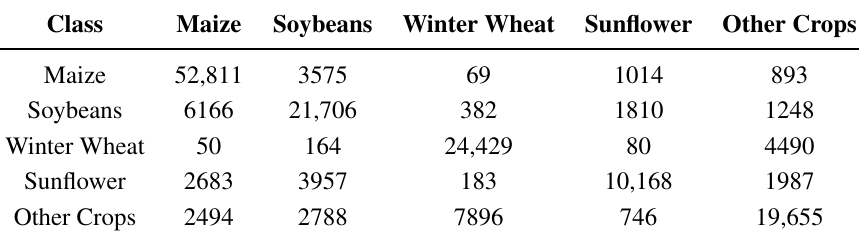
Table 6. Confusion matrix for SVM on the Ukraine test